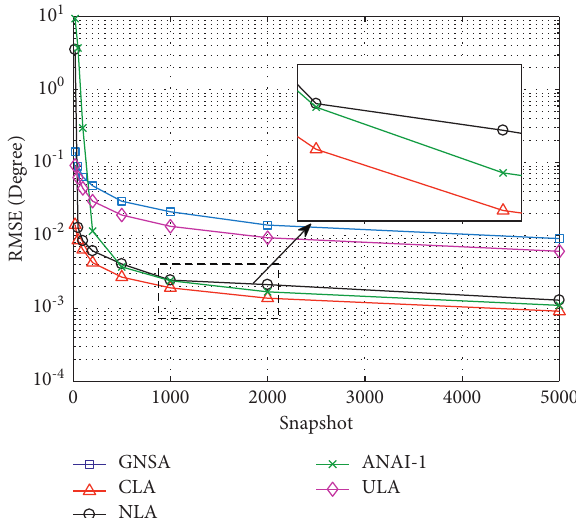
Figure 6: The RMSE versus the number of snapshots in different sparse arrays using spatial